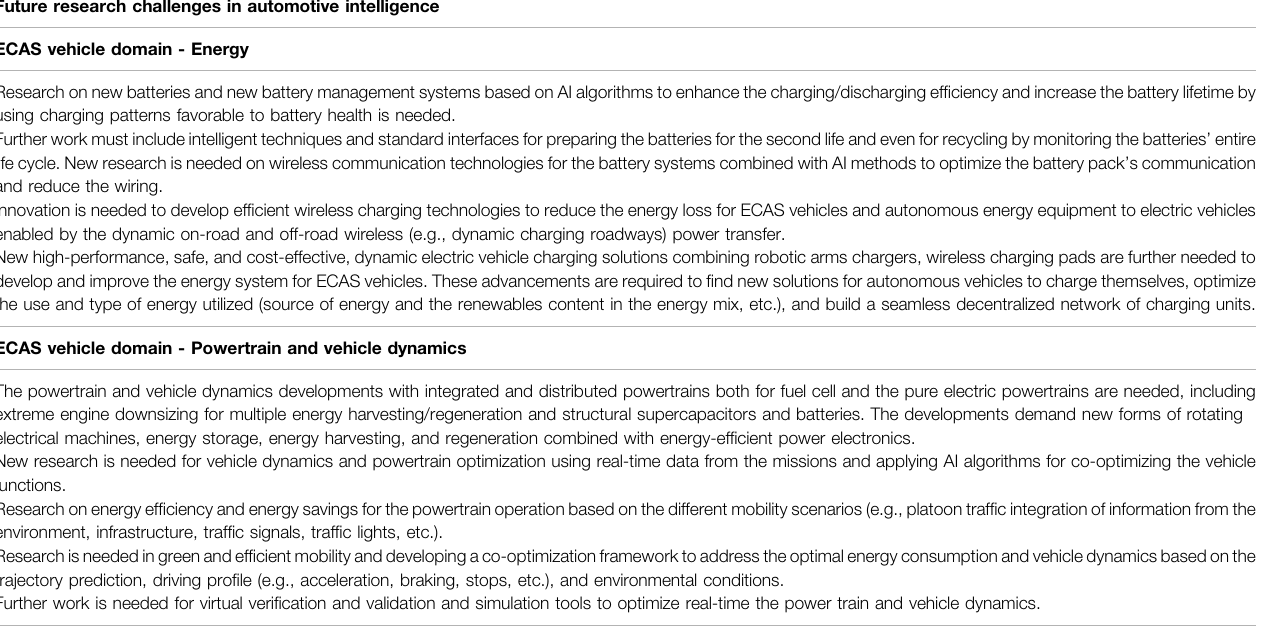
TABLE 3 | ECAS vehicle future research